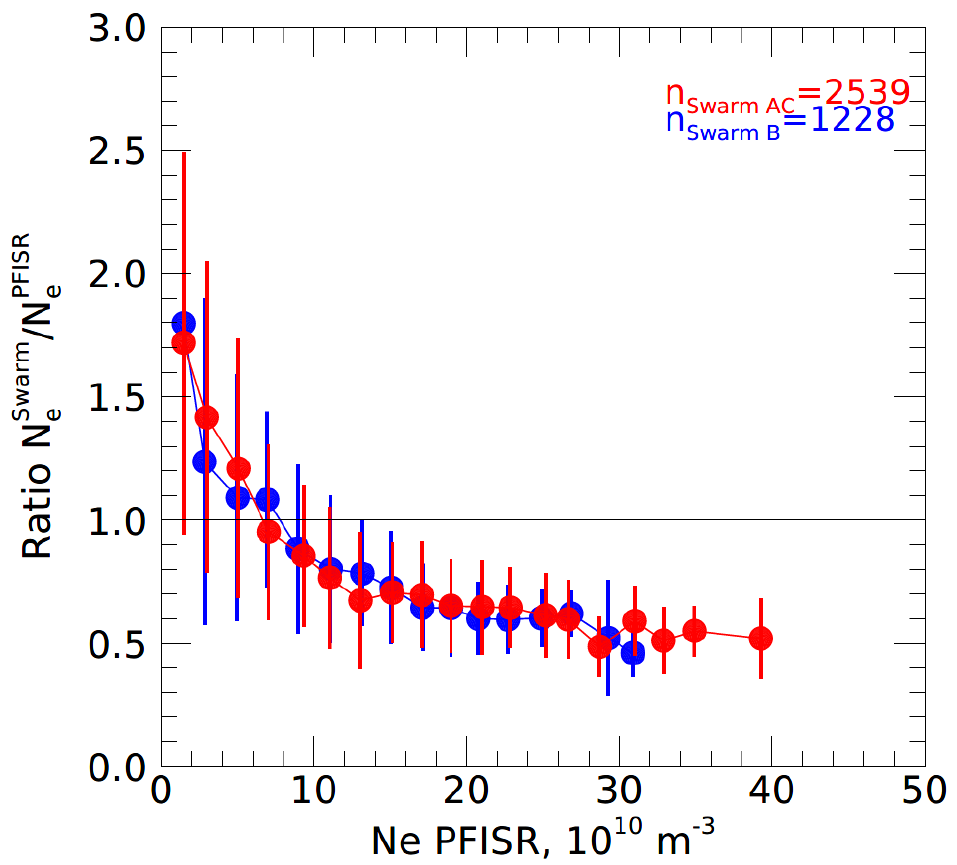
Figure 5. Medians of the ratio R = N eSwarm /N ePFISR as a function of the electron density measured by PFISR, N ePFISR . The bins of N ePFISR have a step of 2 × 10 10 m − 3 . Vertical bars for each bin are the median value of the ratio +/ − one standard deviation of the ratio. Red and blue colors characterize data for PFISR conjunctions with Swarm AC and Swarm B, respectively.